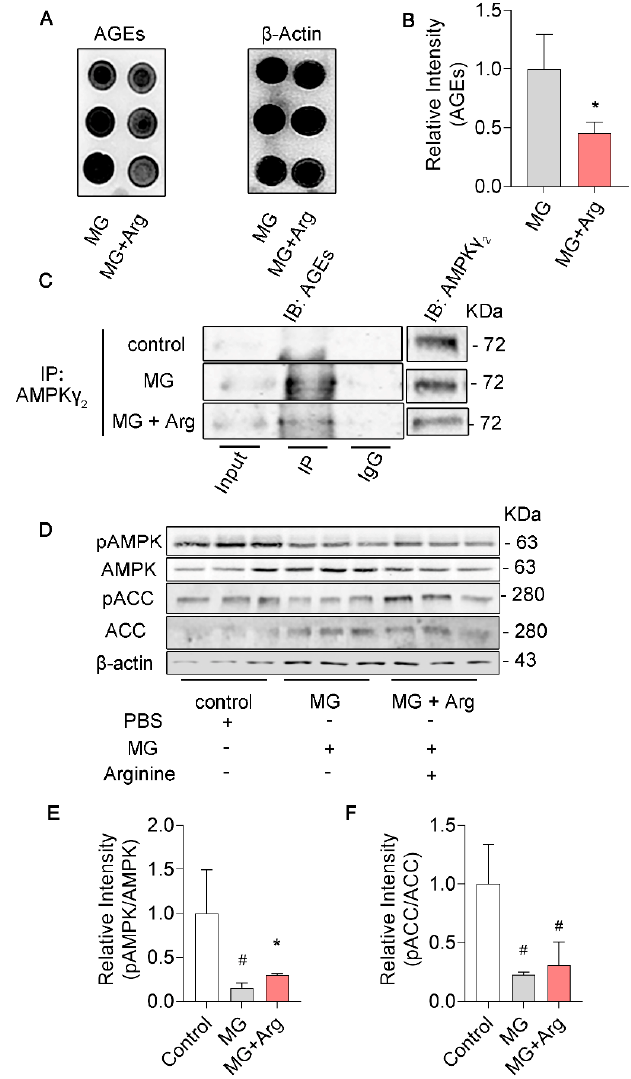
Figure 3. Arginine mitigates glycation in γ 2 subunit of AMPK induced by MG and maintains the AMPK function in N2a cells. ( A , B ) The glycated proteins were detected and analyzed by dot blot with antibody against AGEs. ( C ) The N2a lysates were immune − precipitated with antibody against AMPK γ 2 , followed by western blot with antibody against AGEs. ( D – F ) The level of pT172 − AMPK, AMPK, pS79 − ACC, and ACC were measured and analyzed by western blot in MG, MG + Arg groups. All data are presented as the means ± SD ( n = 3), statistical analysis with one − way ANOVA with a post hoc Turkey’s test. * p < 0.05 vs. MG; # p < 0.05 vs.